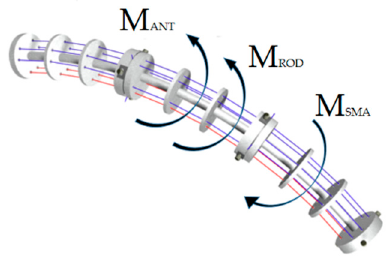
Figure 6. Moments acting on the actuator in the equilibrium condition.